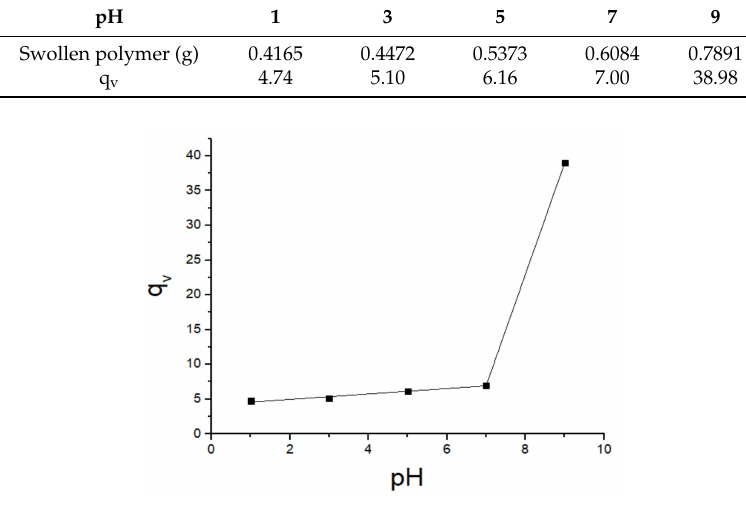
Figure 13. q v values against di ff erent pHs of the SAP in